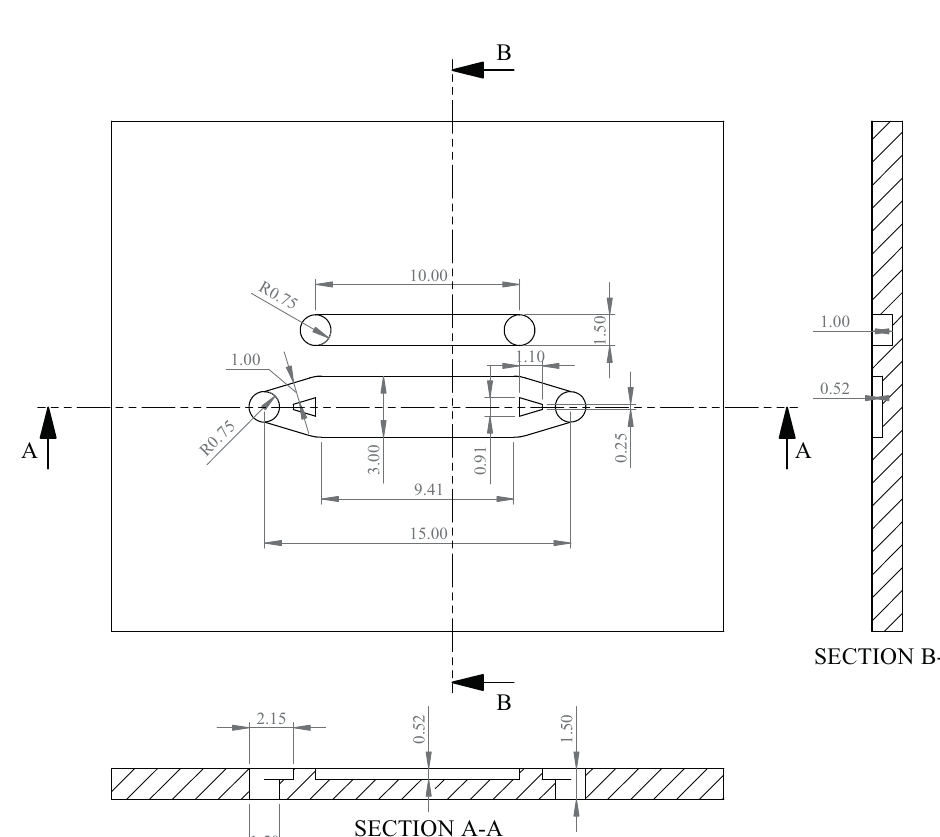
Figure A1. Technical drawing of the DNA amplification chip. All dimensions are in mm. The total chip size is 3mm by